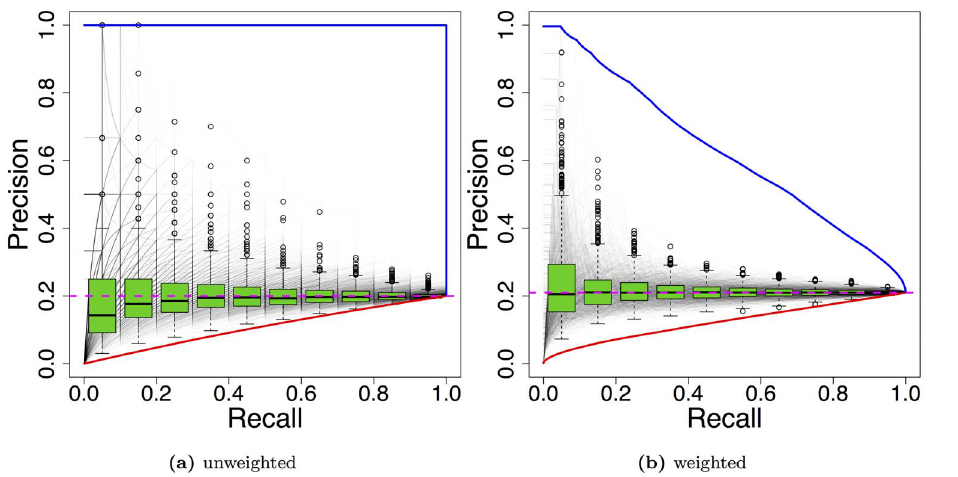
Figure 1. Precision recall curves for data set with 100 data points and class ratio 1 to 4. The blue and the red curve indicate estimators of the best and the worst curve, respectively. The gray curves represent 1,000 PR curves based on a random scored-based classifications, which are also summarized by the green boxplots. The pink dashed line indicates the level of the class ratio R fg